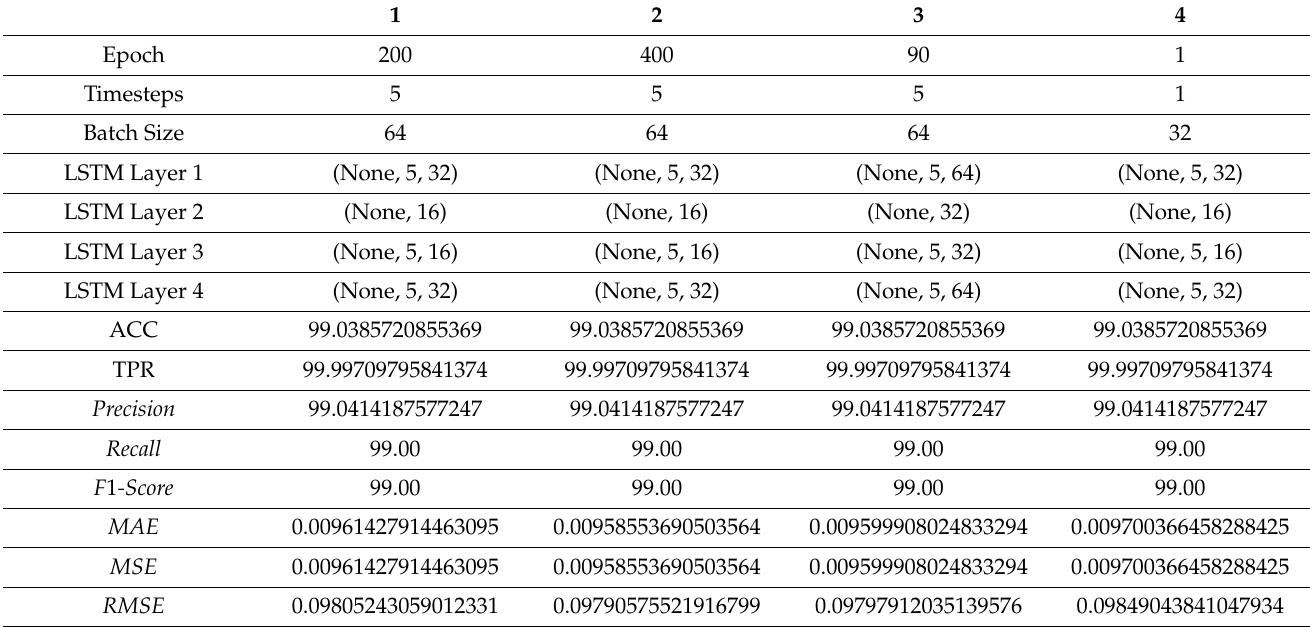
Table 6. RoMADS results for different training